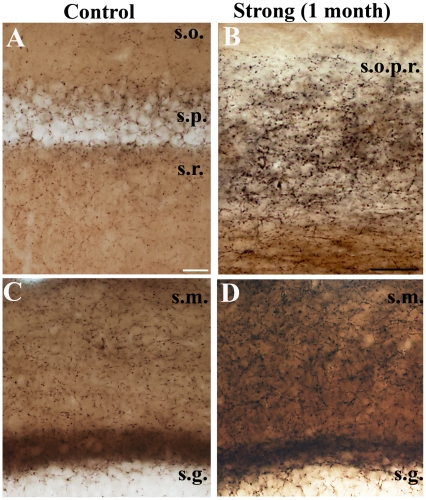
Changes in CB1-R-staining in the chronic phase.CB1-R immunostaining in the hippocampi of control (A, C) and chronically epileptic, sclerotic mice (1 month post pilocarpine)(B, D). In the sclerotic samples the general CB1-R immunostaining is much stronger throughout the hippocampus. In the CA1 (A) a dense immunostained axonal plexus can be seen in the sclerotic CA1 region (layers cannot be distinguished) (B). In the dentate gyrus stained fibers establish more dense meshworks (D). Scales: A, C, D: 50 µm B: 20 µm.